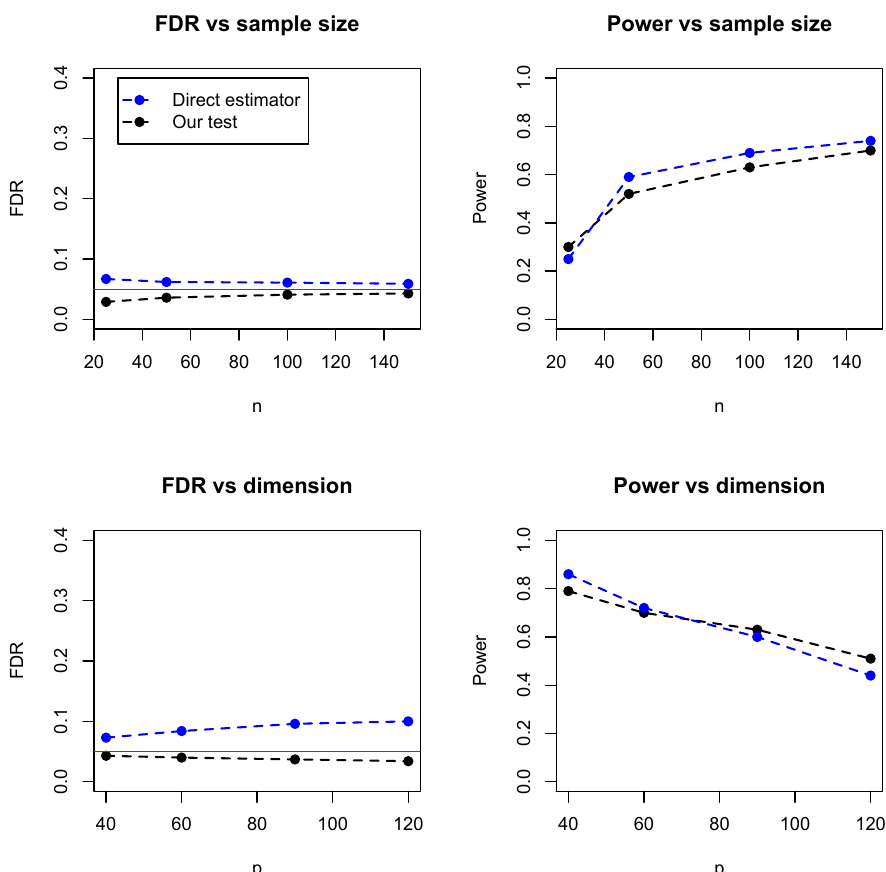
Figure 5. Comparison of the proposed test and direct estimator by Zhang (2019), in terms of empirical FDR and statistical power under different sample sizes and